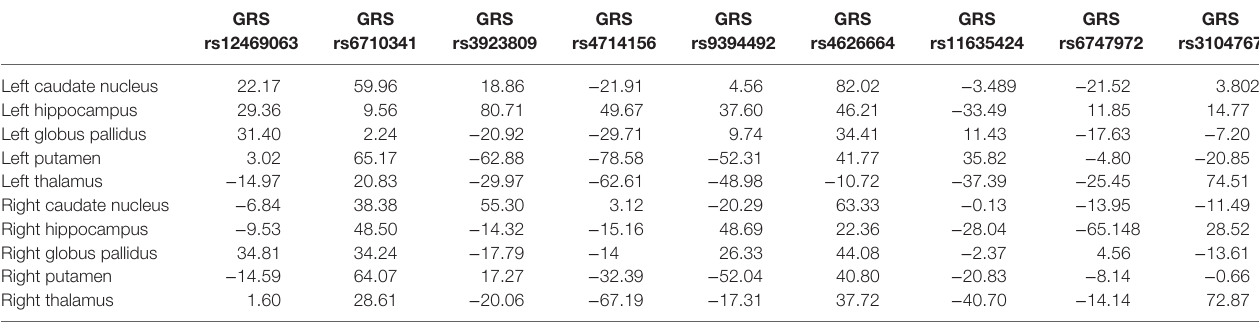
TaBle 4 | Regression coefficients for the GRS per subcortical